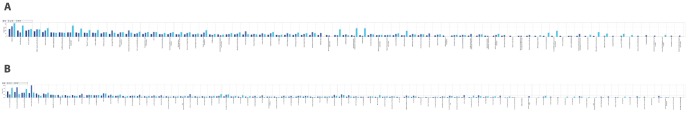
Global functional analysis and comparison of the three datasets.The significance value associated with a function in Global Analysis is a measure of probability that genes from the dataset under investigation participate in that function. (A) Bio-function analysis and comparison; (B) Tox-function analysis and comparison.